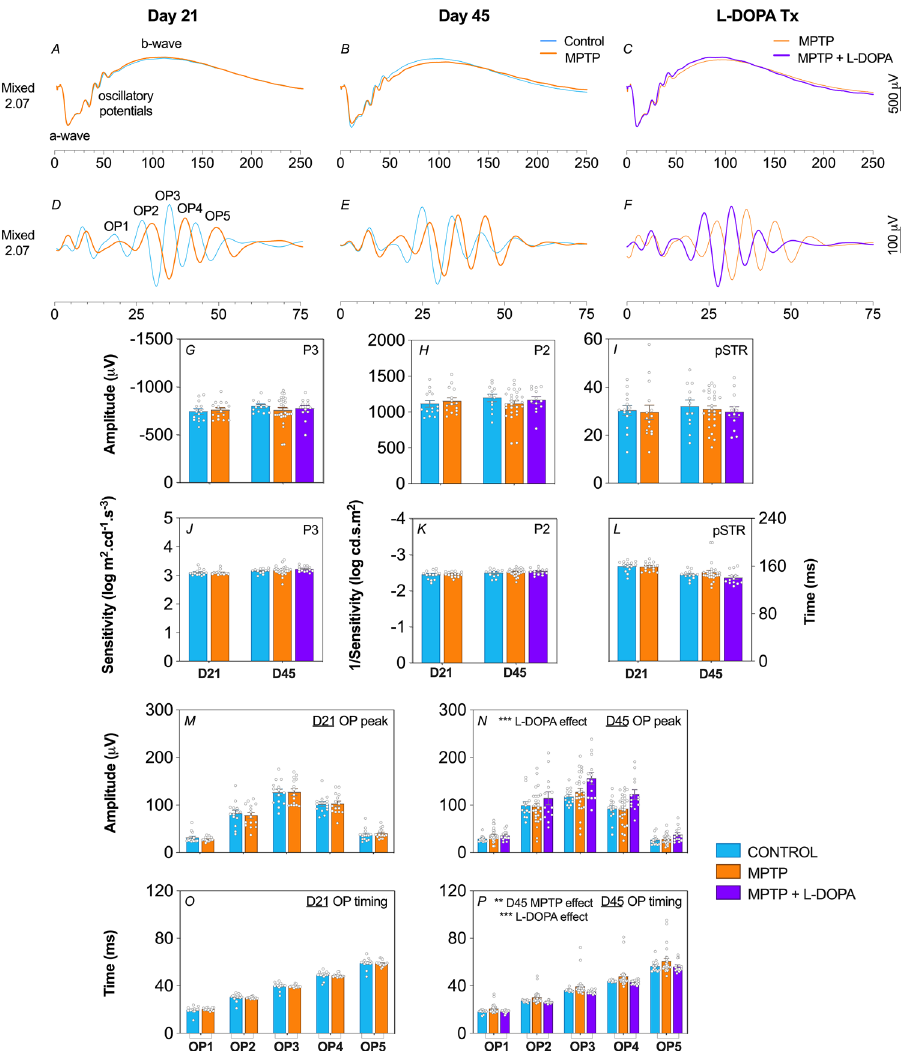
Figure 3. Effect of MPTP and L-DOPA on in vivo retinal function of the dark-adapted pathway. Averaged mixed rod and cone ERG waveforms ( A – C ) in response to a bright flash (2.07 log cd s/m 2 ) eliciting photoreceptoral (P3) and ON-bipolar cell (P2) responses. Representative oscillatory potential (OP) waveforms ( D – F ) (2.07 log cd s/m 2 ). Group average (± SEM) P3 ( G ), P2 ( H ) and positive scotopic threshold response (pSTR, ( I )) peak amplitudes (μV). Group average (± SEM) P3 ( J ) and P2 ( K ) sensitivity. Group average (± SEM) pSTR ( L ) timing (ms). Group average (± SEM) OP1 to OP5 amplitude ( M , N ) and timing ( O , P ) of Day 21 and Day 45 animals, respectively. Day 21 cohort (D21): control (n = 14, blue) vs. MPTP (n = 15, orange). Day 45 cohort (D45): control (n = 12, blue) vs. MPTP (n = 27, orange) vs. MPTP + L-DOPA (n = 13,